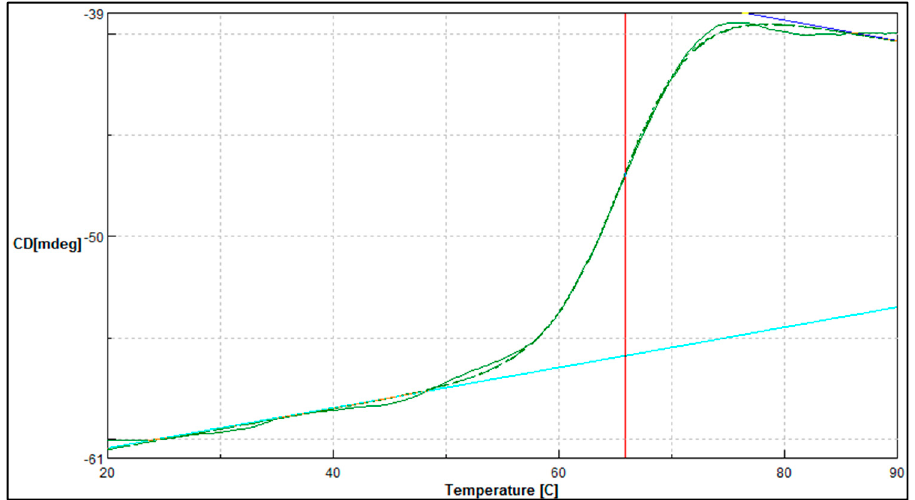
Figure 8. Thermal denaturation profile of purified A. geothemalis ALDH. Vertical line (red) indicates the melting point value when tested from temperature ranging from 20 to 90 °C.